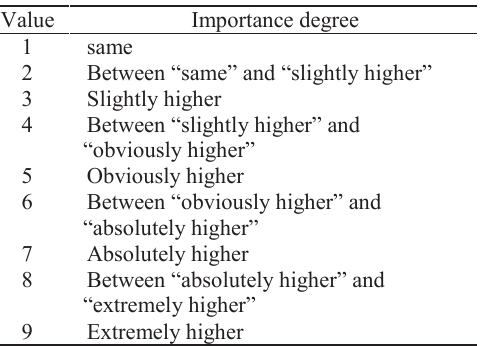
Table 1. Grade criteria of DTPs